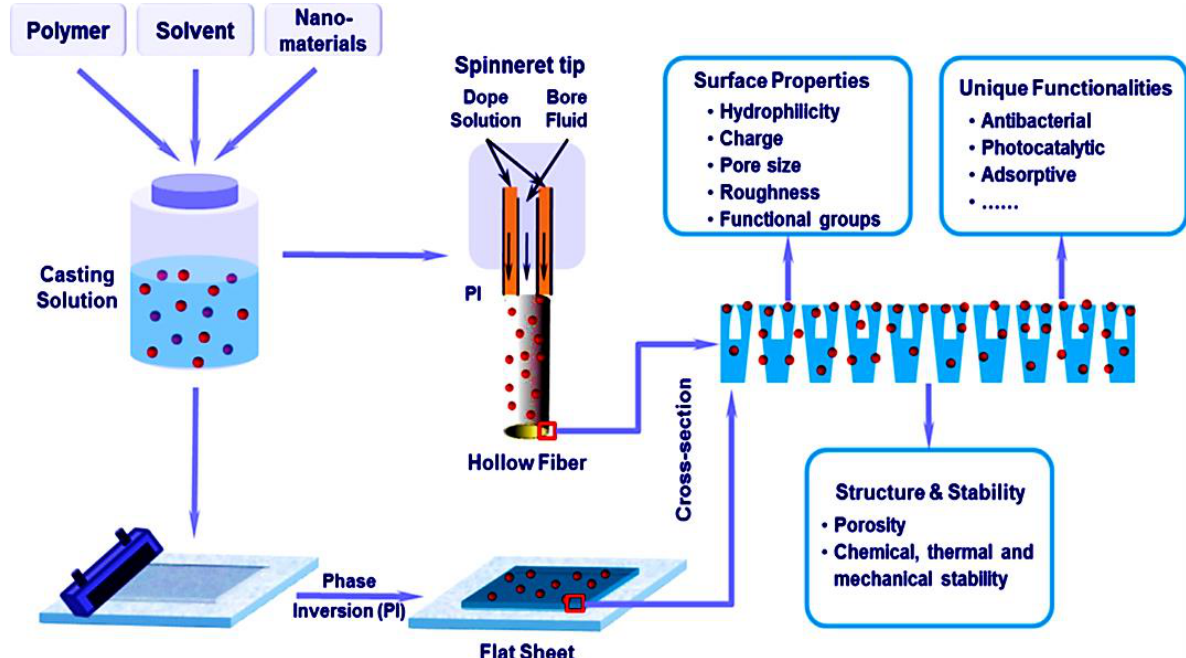
Figure 6. Fabrication of conventional nanocomposite membranes. Reproduced with permission from reference [15] Copyright 2015